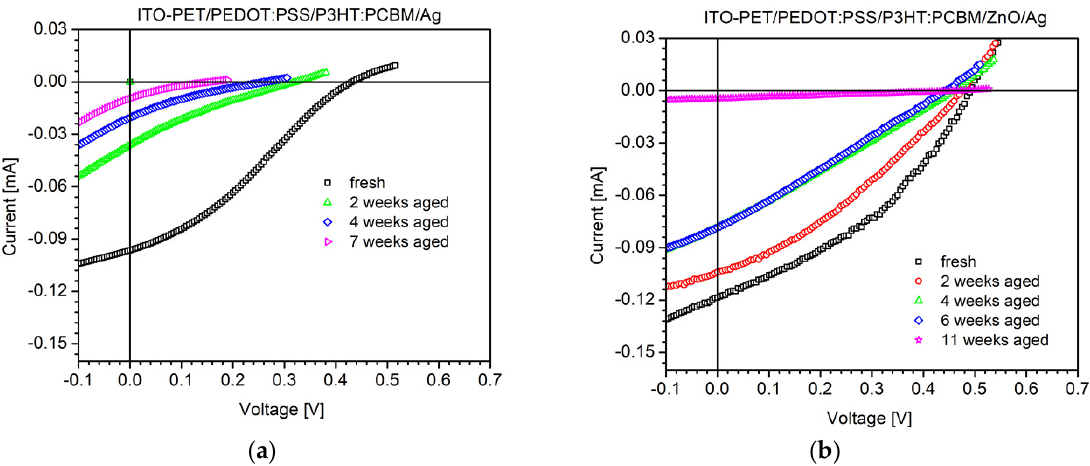
Figure 6. Change in I–V characteristics of P3HT:PCBM-based solar cells on flexible PET substrates constructed under environmental conditions after degradation: ( a ) without presence of ZnO nanoparticles ETL and ( b ) in the presence of ZnO nanoparticles ETL.